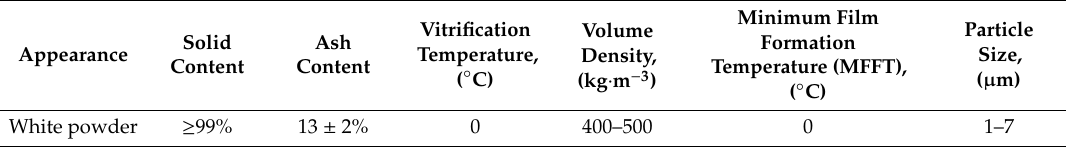
Table 1. Main indexes of redispersible emulsion